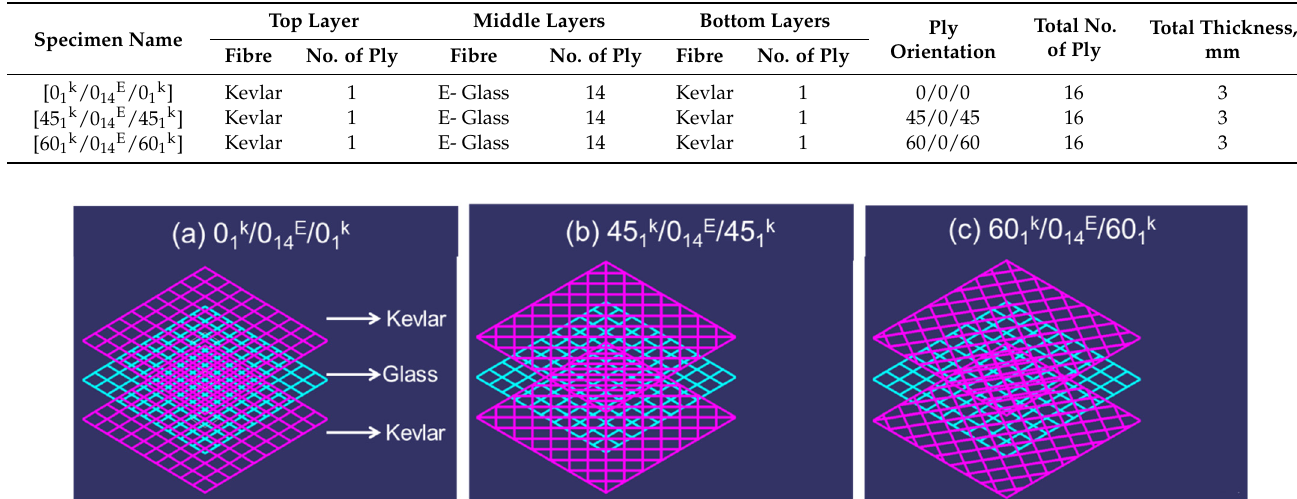
Table 1. Composite laminate formulation.